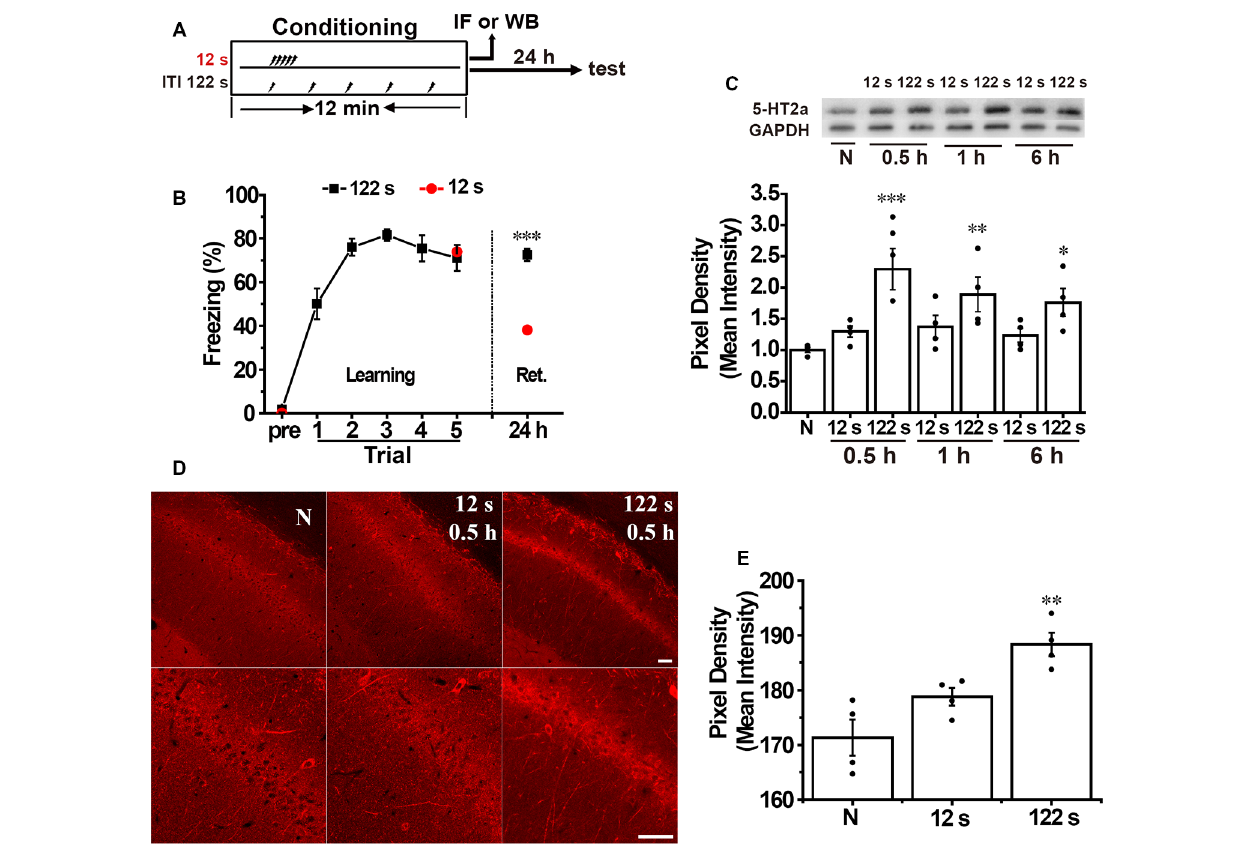
FIGURE 1 | Spaced training enhances hippocampal 5-HT2A receptor expression and contextual fear memory. (A) Diagram for experimental procedures. (B) The spaced training group (122 s) showed a heightened contextual fear memory compared with the massed training group (12 s) at 24 h after training ( n = 10 for each group). (C) Western blotting analysis showed that spaced but not massed training increased hippocampal 5-HT2A receptor expression at 30 min (0.5 h), 1 h, and 6 h after contextual fear conditioning compared with the naïve group ( n = 4 for each group). (D) The 5-HT2A receptor positive staining in the hippocampal CA1 area significantly increased in the spaced but not in the massed group at 0.5 h after contextual fear conditioning [ p < 0.05, (E) ]. Scale bar = 50 µ m. (E) Bar graph of ( D ; n = 4 for each group). All results were presented as mean ± SEM. ∗ p < 0.05, ∗∗ p < 0.01, ∗∗∗ p <